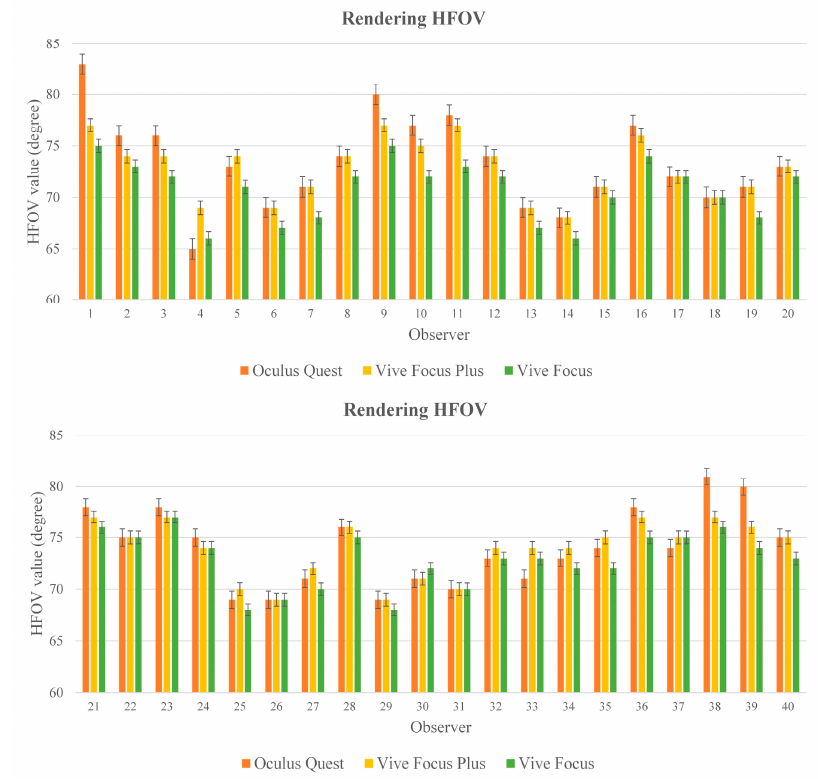
Figure 6. Observer’s HFOV of three VR HMDs.